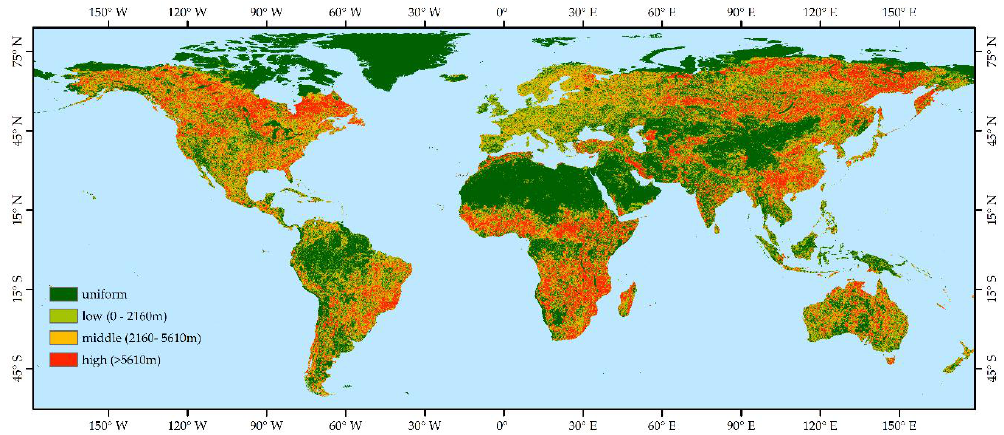
Figure 7. Global boundary length map at 1-km resolution. The boundary lengths were classified into four categories by quantile. The longest 25% were taken as high fragmented; the boundary lengths between the top 50 and 25% were considered to be middle fragmented.